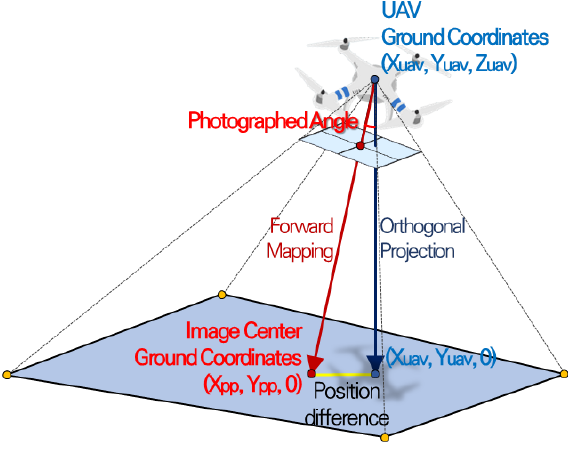
Figure 2. Body stability analysis